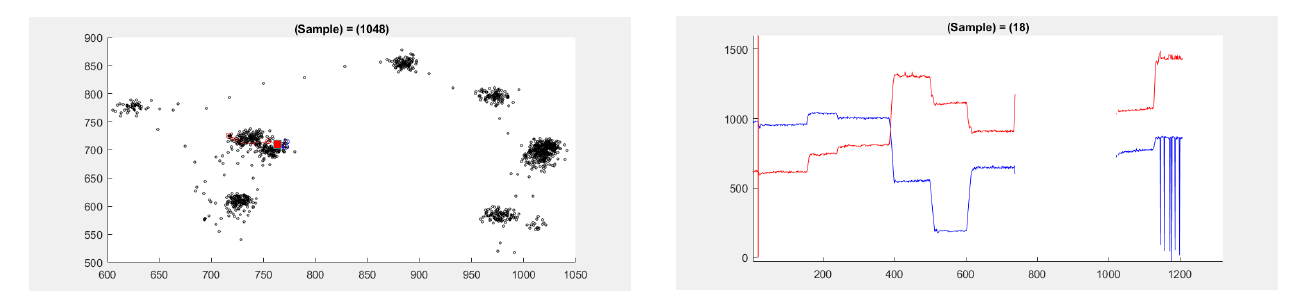
Figure 12 . Position plot for dataset 2.3 at samples 17–19 (red line at sample 18) shows a small jump in the mean.